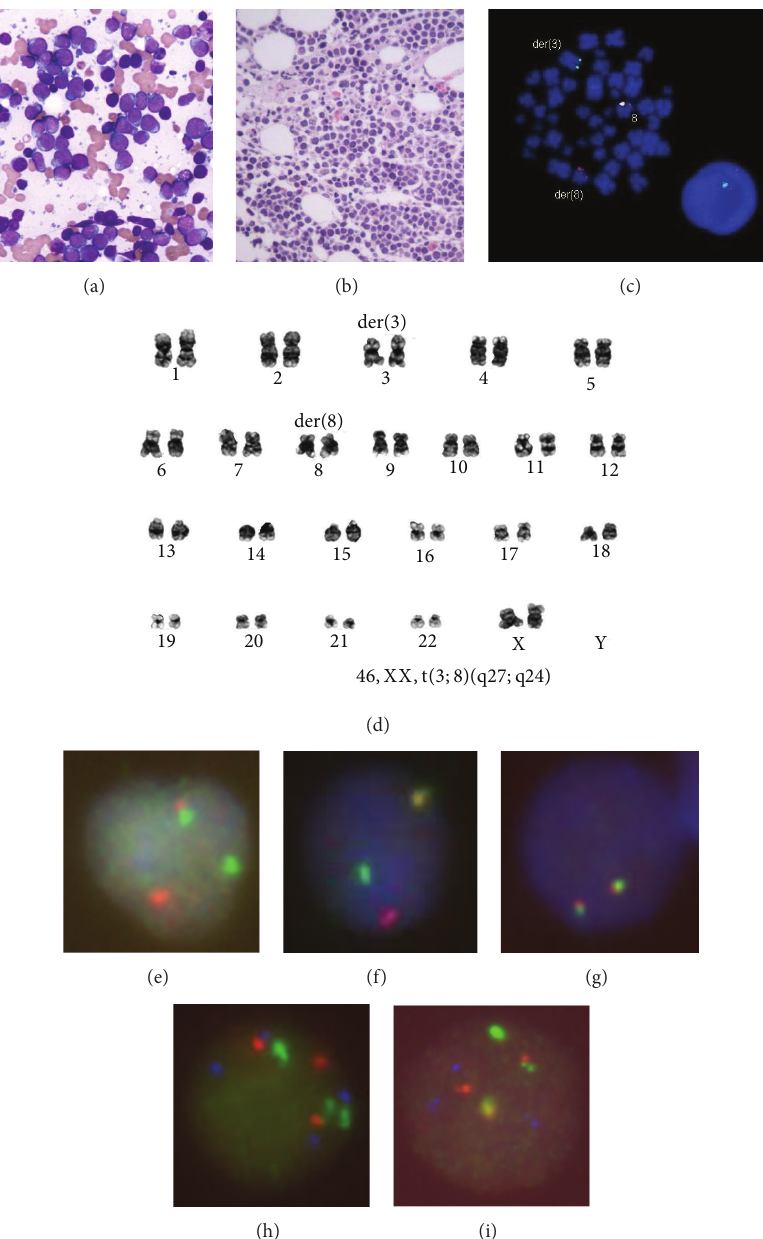
Figure 1: Morphology, karyotype, and FISH analysis of the case. (a) Blast cells demonstrating basophilic cytoplasm and high nuclear cytoplasm ratio. (b) Bone marrow morphology showing diffuse infiltration. (c) Analysis of bone marrow metaphase using FISH probes. A Vysis LSI MYC dual colour break-apart rearrangement probe was employed to show a MYC fusion on the normal chromosome 8, with the other MYC allele split between the der(3) and der(8). (d) G-banding karyogram showing t(3;8)(q27;q24). ((e), (f), and (g)) Interphase FISH analyses (false colour display derived from the ISIS/MetaSystems FISH system). (e) FISH analysis of the t(3;8) translocation. (e) MYC break-apart probe showing one red/green colocalised signal from the unrearranged locus and two separate red and green signals from the rearranged locus. (f) BCL 6 break-apart probe showing one red/green colocalised signal from the unrearranged locus and two separate red and green signals. (g) IGH break-apart probe showing a signal of two colocalised red/green signals indicating no breaks at the IGH locus. (h) MYC / IGH / CEP 8 tricolor dual-fusion probe. IGH (green) does not colocalise with MYC (red). The 8p11.1-q11.1 CEP8 alpha satellite probe gives a blue signal. (i) Colocalisation of BCL 6 (green) and MYC (red) without fusion of IGH signals